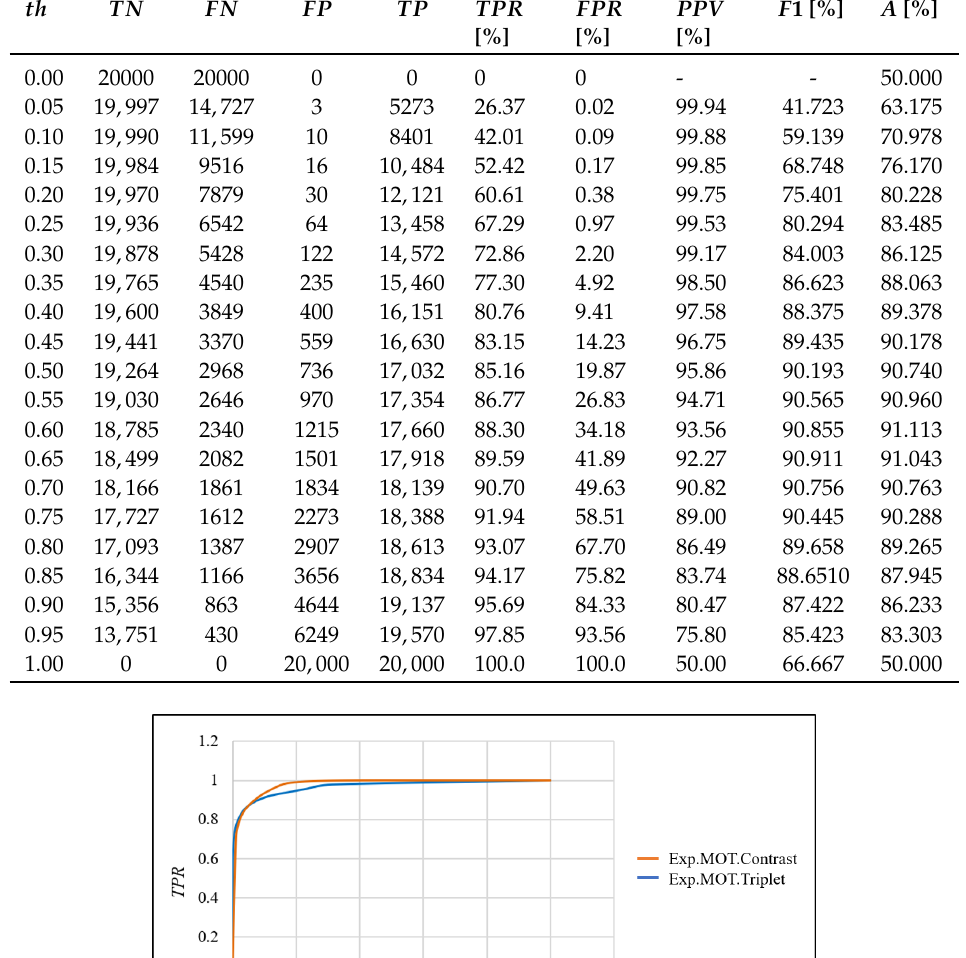
Table 4. Binary classification metrics for the Appearance Affinity model learnt with the Triplet loss function.